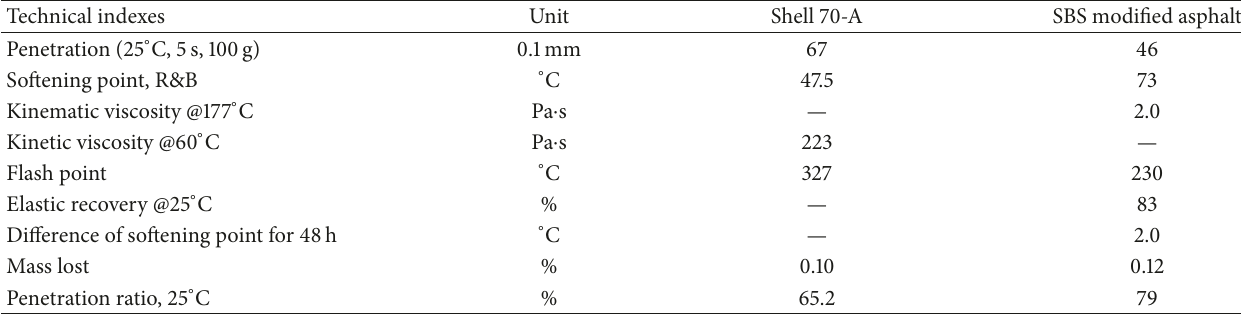
Table 1: Technical indexes of asphalt binders.